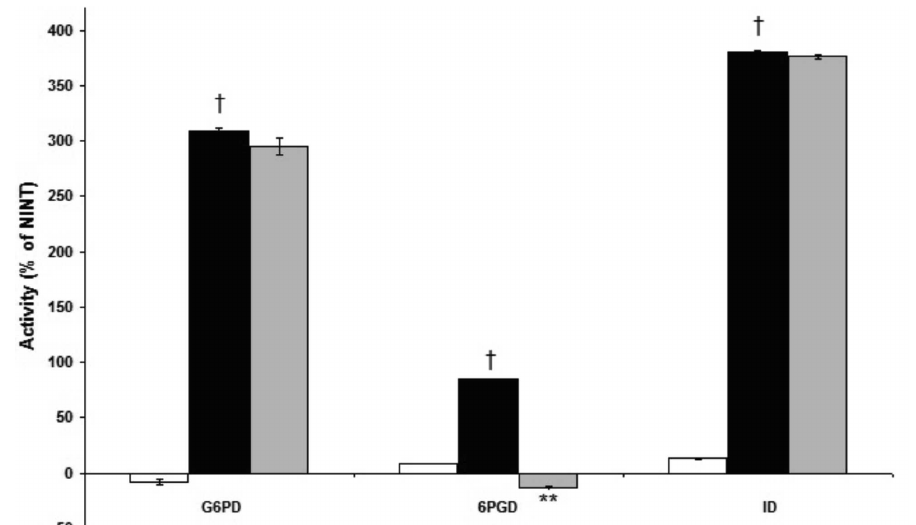
FIGURE 3 - NADPH + H + -producing dehydrogenase enzymes in Plasmodium berghei -infected erythrocytes treated with clotrimazole (CTZ). Results are expressed as the mean ± SEM of the percentage of activity compared to non-infected and non- treated erythrocytes (NINT) (basal line). G6PD: glucose-6-phosphate dehydrogenase; 6PGD: 6-phosphogluconate dehydrogenase; ID: isocitrate dehydrogenase; NI + CTZ: non-infected red blood cells and treated with CTZ (white bars); I: infected erythrocytes (black bars); I+CTZ: infected red blood cells and treated with CTZ (gray bars); † p <0.05 compared to NINT; ** p <0.01 compared to TABLE I - Effect of clotrimazole (CTZ) on the glutathione cycle in Plasmodium berghei -infected erythrocytes Treatment